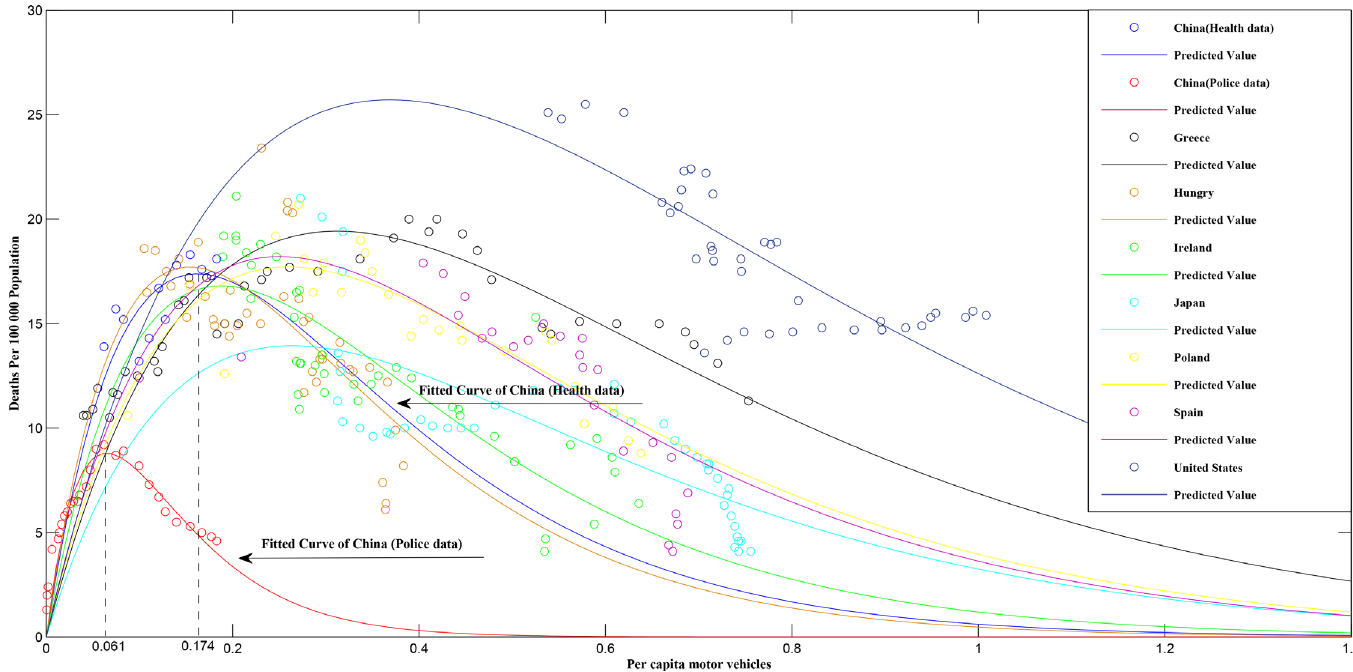
Fig 1. Fitted curves between road traffic mortality and per capita motor vehicles based on modified Smeed equation.